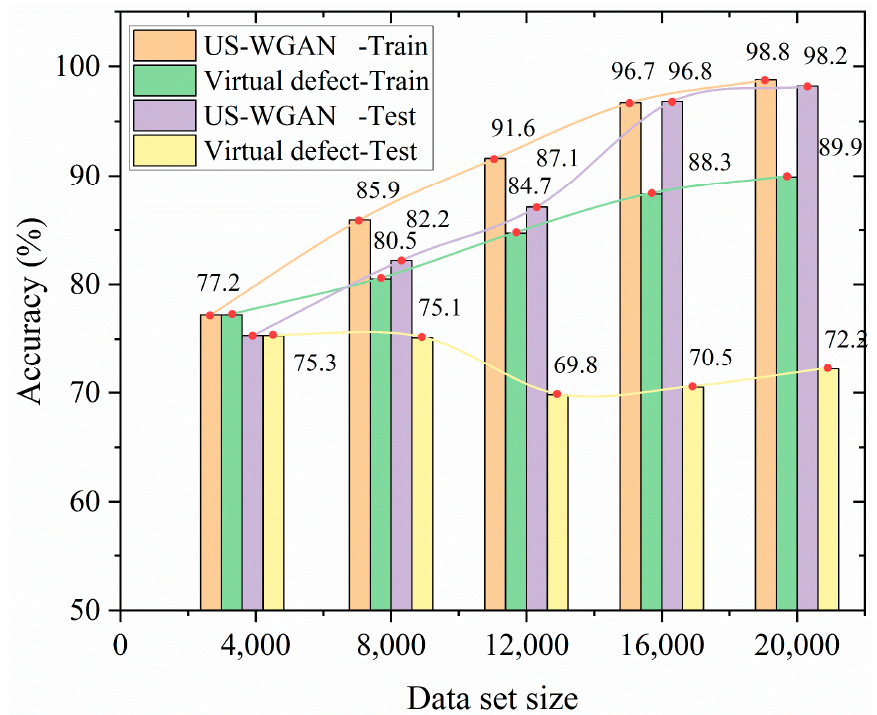
Figure 8. Train and test accuracy for deep fully connected neural networks with respect to dataset size for virtual defect and US-WGAN data enhancement methods.